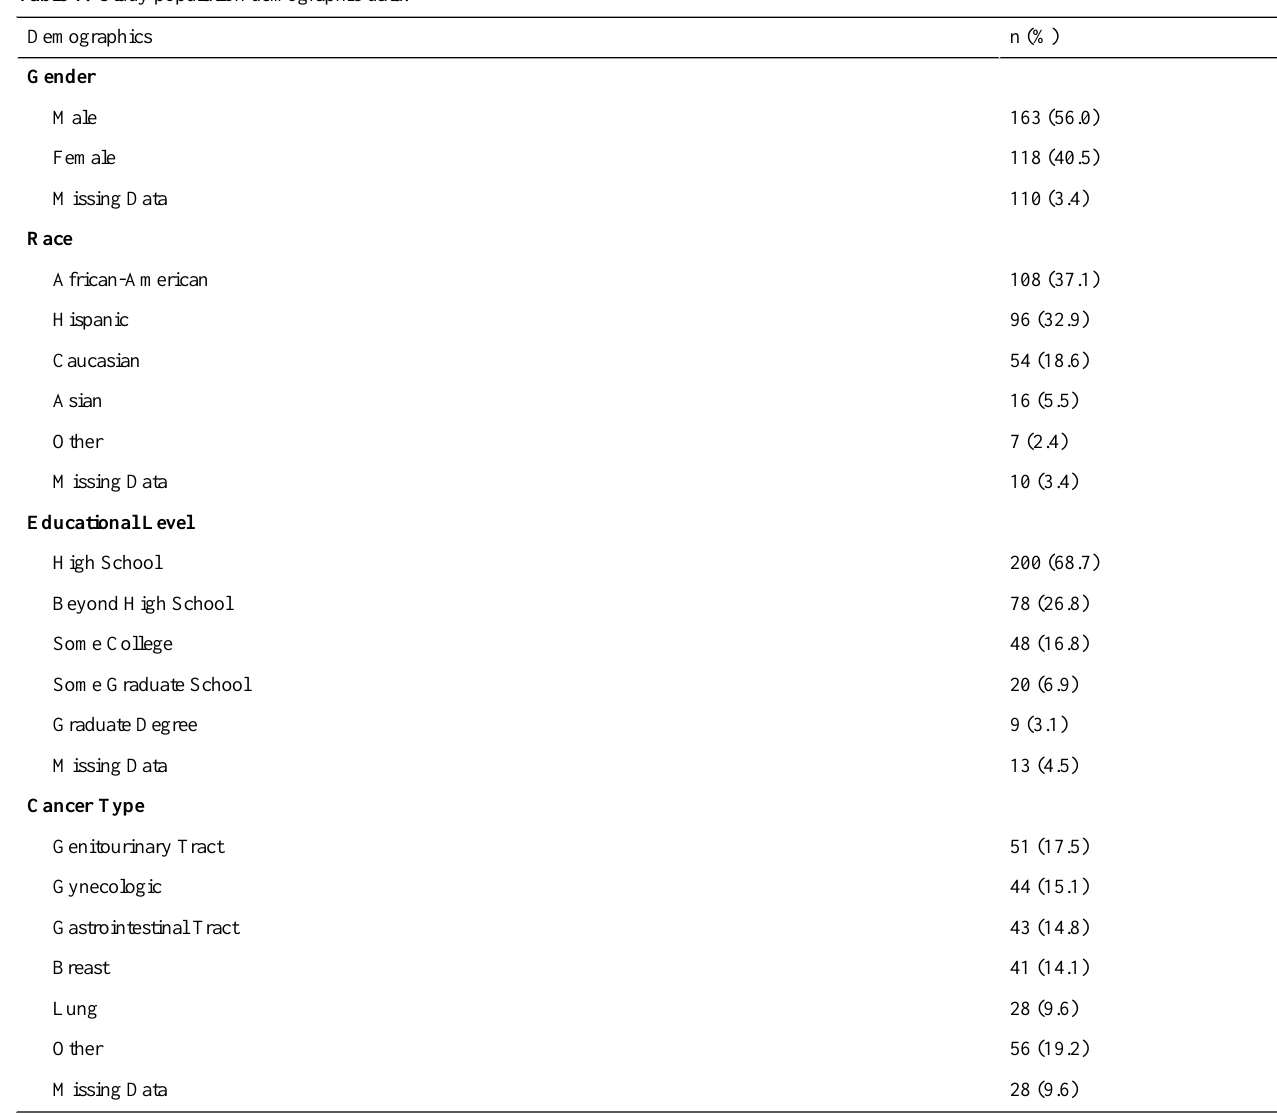
Table 1. Study population demographic